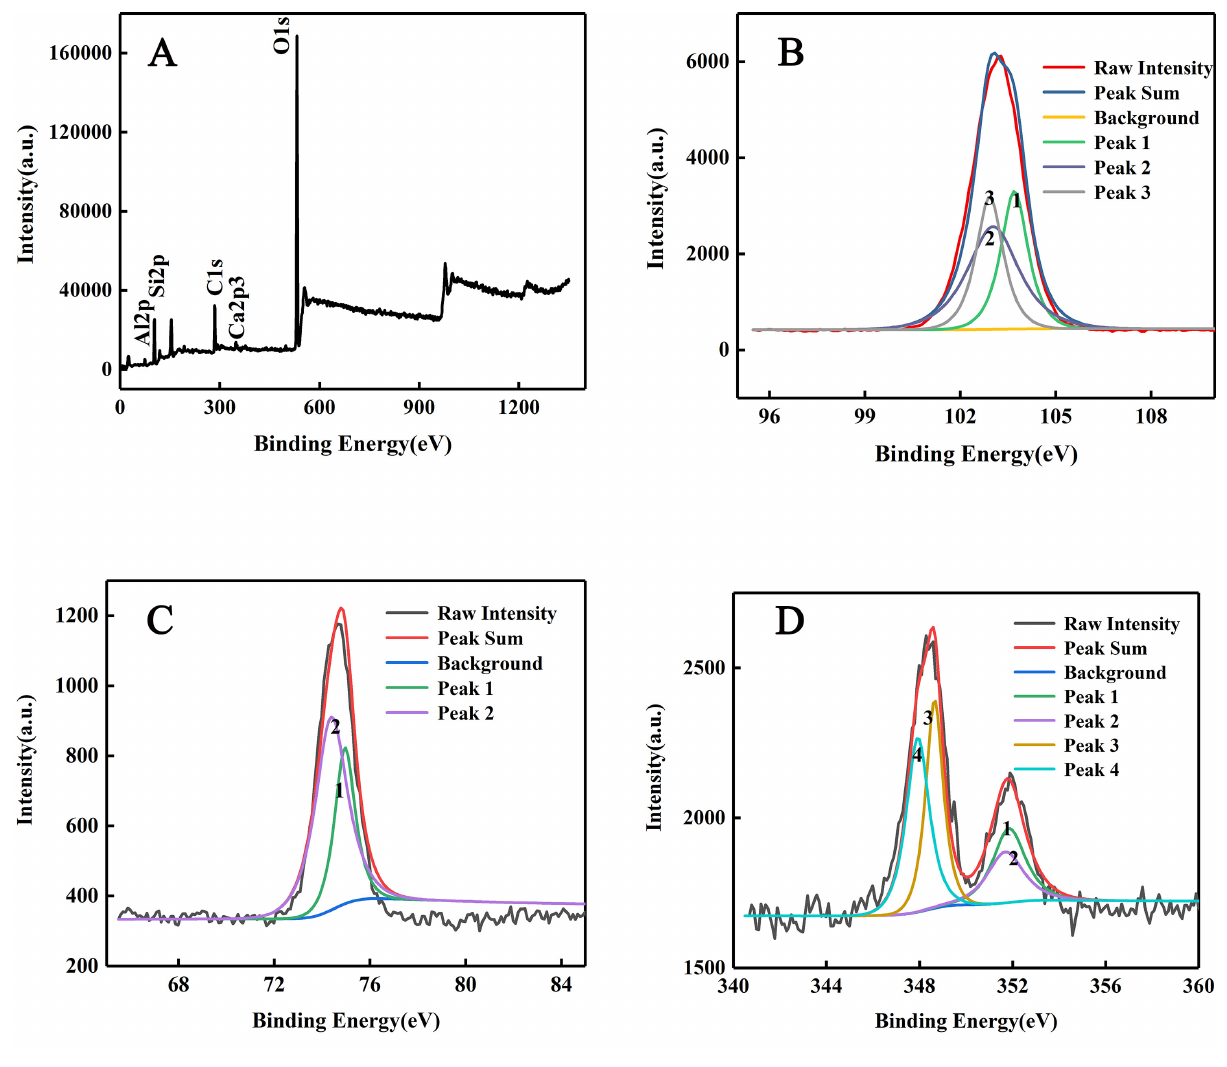
Figure 2: XPS patterns of the composite with CaO content of 2.8 wt.% sintered at 850 ∘ C Table 2: Properties of the composites in comparison with commercial LTCC materials